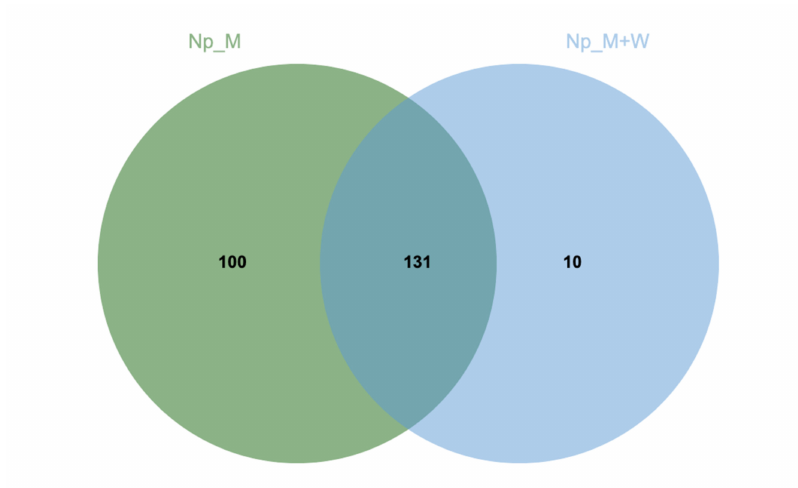
Figure 1. Venn diagram of N. parvum secreted proteins in malt medium (green) and in malt medium supplemented with grapevine sawdust (blue) adapted from [48]. Secreted proteins were extracted from two replicates.